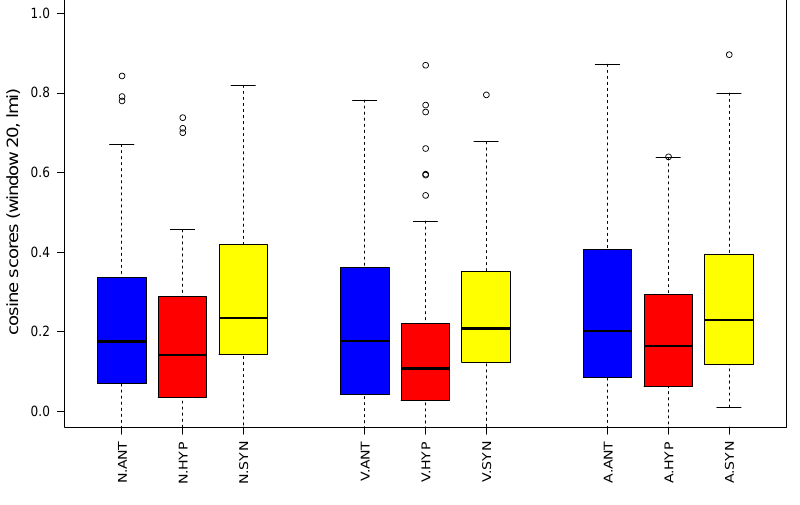
cosine scores across classes and relations (window